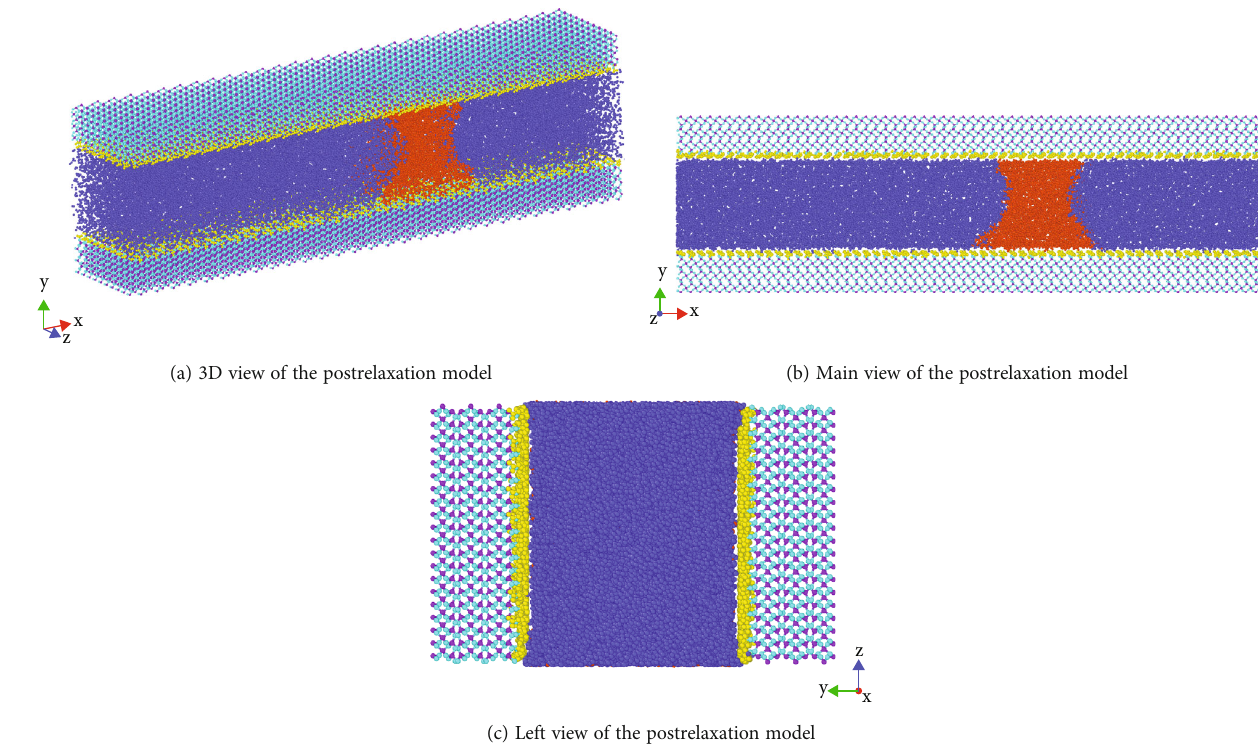
Figure 4: Pictures of postrelaxation model (red: crude oil molecules; blue: water molecules; yellow: methyl group; cyan: silicon atoms in walls; and violet: oxygen atoms in walls). Table 1: Potential function parameter